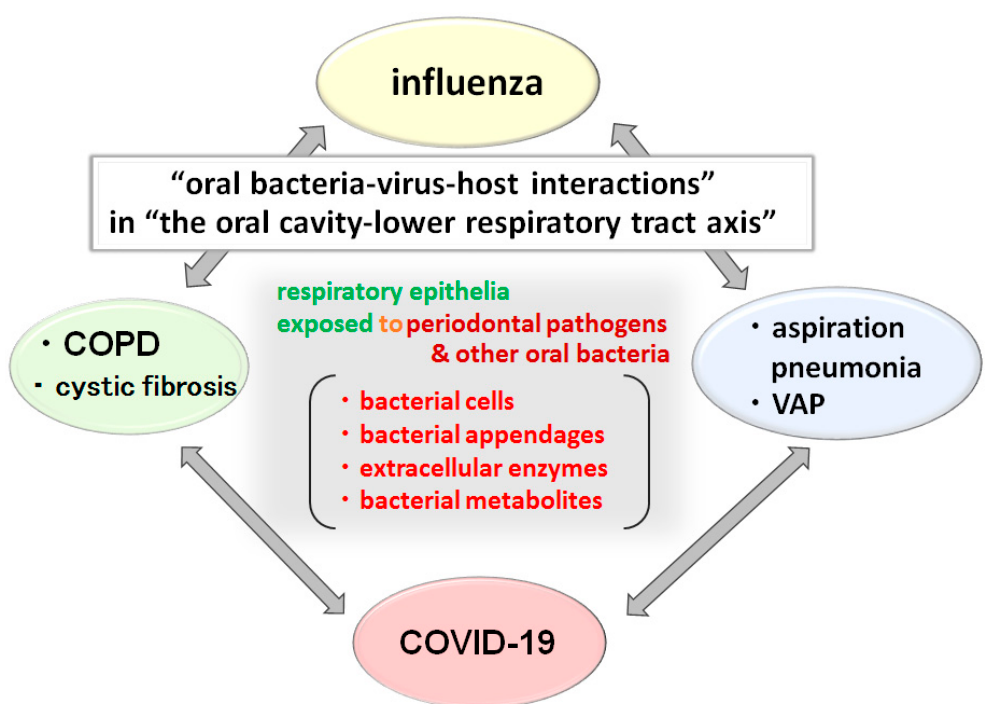
Figure 7. Several “oral bacteria-virus-host interactions” may be involved in giving rise to systemic diseases in “the oral cavity-lower respiratory tract axis” Pneumonia, COPD, influenza, and COVID-19, which are shown to be associated with oral bacteria, involve inflammation of the lungs as the main symptom. In addition, each disease is associated to one another. Therefore, the elucidation of the mechanism of lower respiratory tract inflammation caused by the contact of oral bacteria, extracellular appendages, such as pili and LPS, and exoenzymes with the respiratory epithelium is anticipated. Furthermore, interpreting the effect of the chronic inflammatory state of periodontal disease on systemic chronic inflammation and developing methods to control it is essential. As a result, instead of focusing on “the pathogenicity of a single microorganism” like past studies have, it is essential to examine microbial interactions, such as “oral bacteria-pneumonia-causing bacteria”, “oral bacteria-influenza virus”, and “oral bacteria-SARS-CoV-2”, especially in “the oral cavity-lower respiratory tract